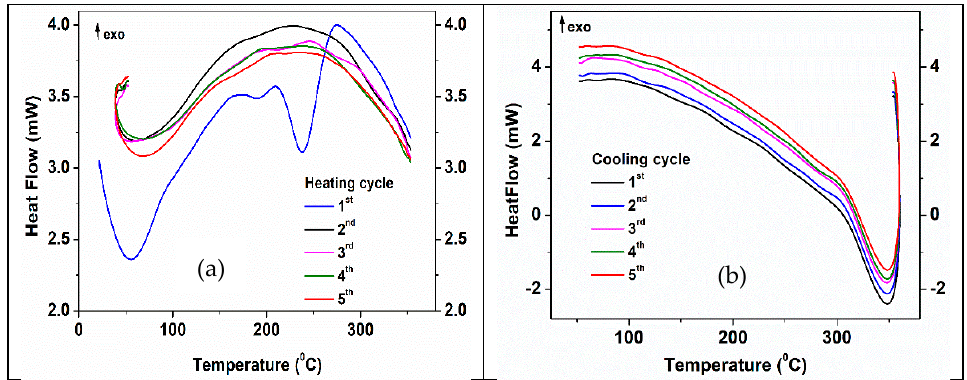
Figure 9. DSC graph of a non-impregnated 3D ZnO-CNT structure: ( a ) 5 heating cycles; ( b ) 5 cooling cycles.